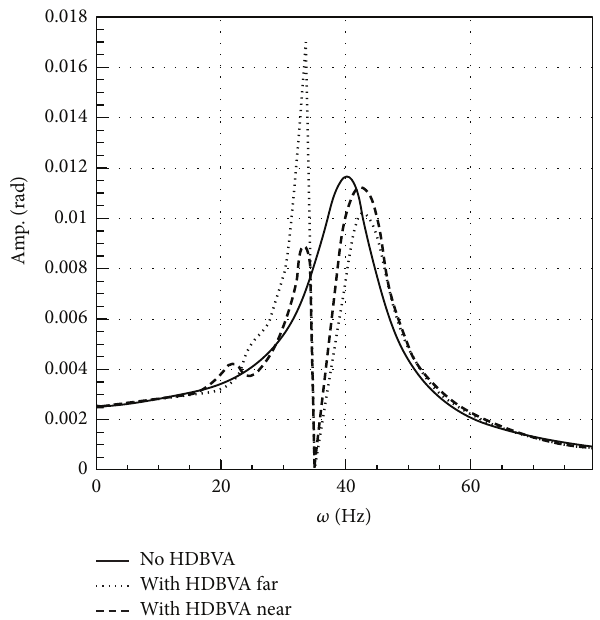
Figure 8: Numerical results of frequency response in 𝜃 𝑌 DOF with lateral groove.